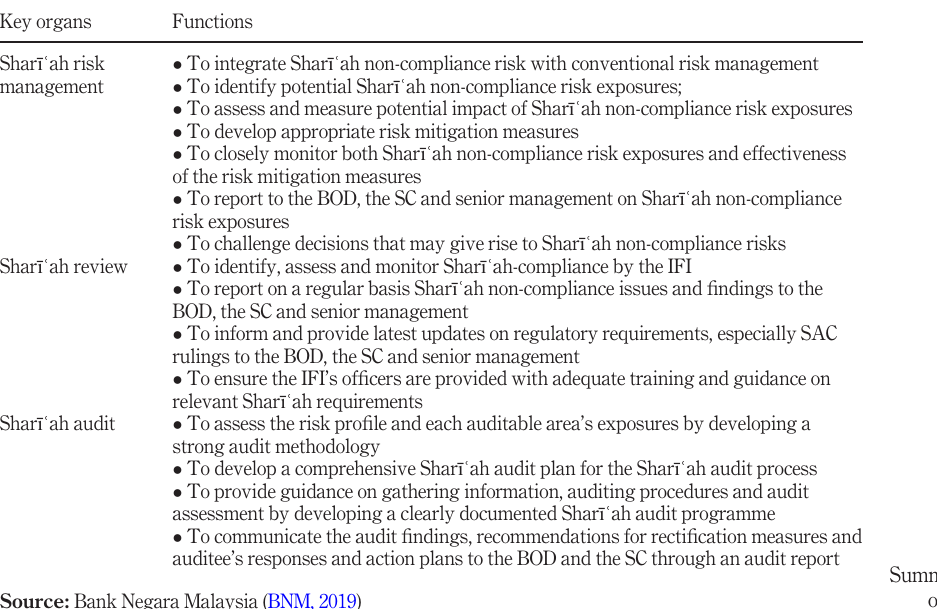
Table 1. Summary of the